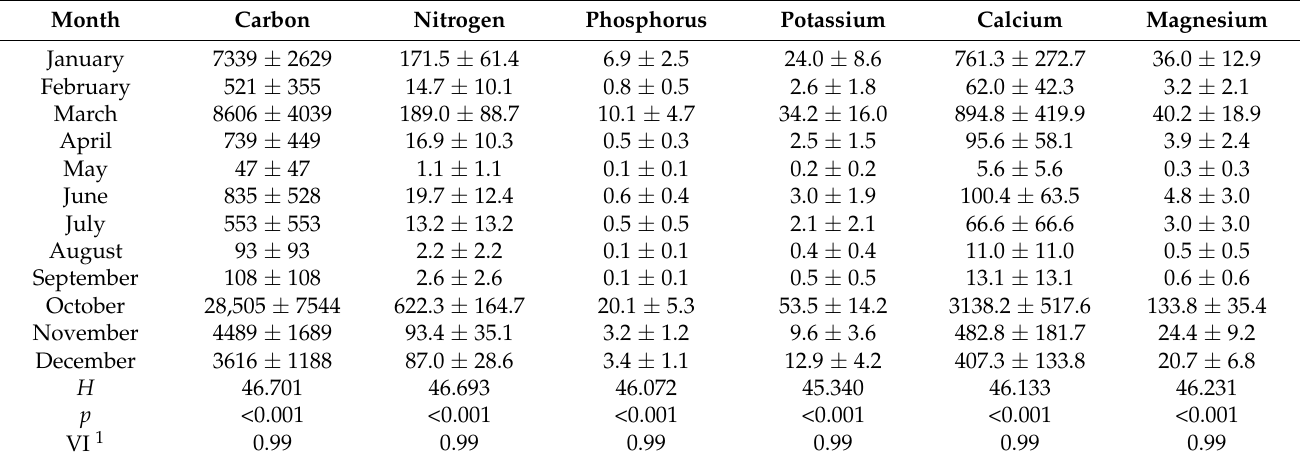
Figure 3. The influence of month on stem litterfall beneath a Serianthes nelsonii tree. Mean ± SE, n = 6. The variation among the months for macronutrient inputs within stem litter pools was greater than for leaf or fruit litter (Table 5). As with fruit litter, the stem litter collected in October consistently contained more of each macronutrient than any other month. In contrast with fruit litter, the month with the least amount of macronutrient input in stem litter varied among the elements. Monthly leaf litter inputs of C were greater than for the other macronutrients with a mean of 4620 mg · m − 2 , and monthly leaf litter inputs of P were less than for the other macronutrients with a mean of only 3.9 mg · m − 2 . Table 5. The influence of month of year on macronutrient return (mg · m − 2 ) in Serianthes nelsonii stem litter.